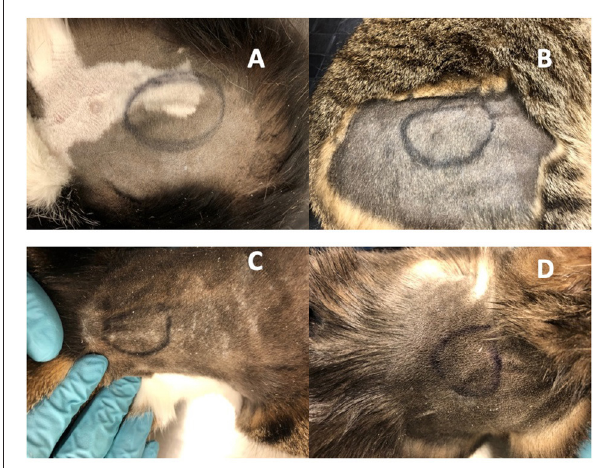
FIGURE 3 | Implanted OKV-119 systems in four purpose-bred cats (A–D) . Images were taken on Day 61 prior to the removal procedure.